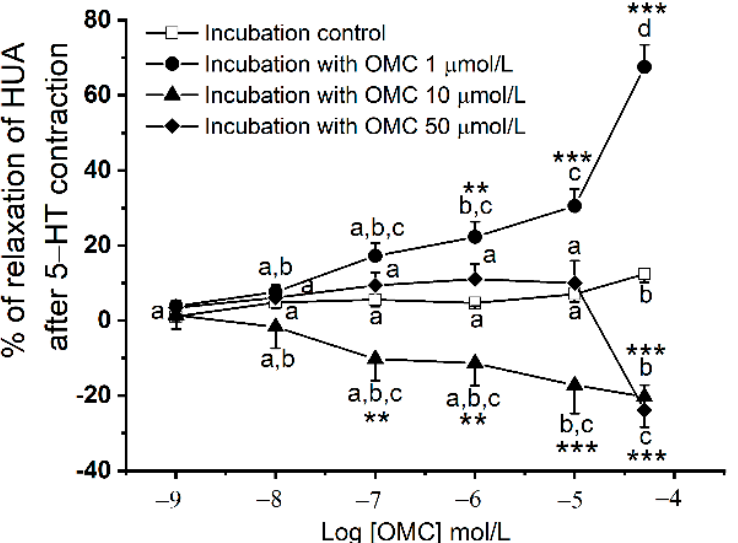
Figure 2. Percentage of relaxation of human umbilical artery (HUA)-rings incubated with octyl- methoxycinnamate (OMC), contracted with serotonin (5-HT; 1 µ mol/L) and exposed to cumulative concentrations of OMC (0.001–50 µ mol/L, which is presented as Log [OMC]). Each point represents the mean and vertical lines represent the S.E.M. * Represents a significant difference when compared to rings from the HUA control: ** ( p < 0.01) and *** ( p < 0.001); and the different letters represent